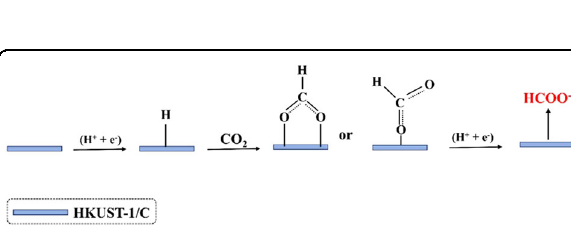
Fig. 7 A plausible mechanism for CO 2 electroreduction catalyzed by the HKUST-1/C